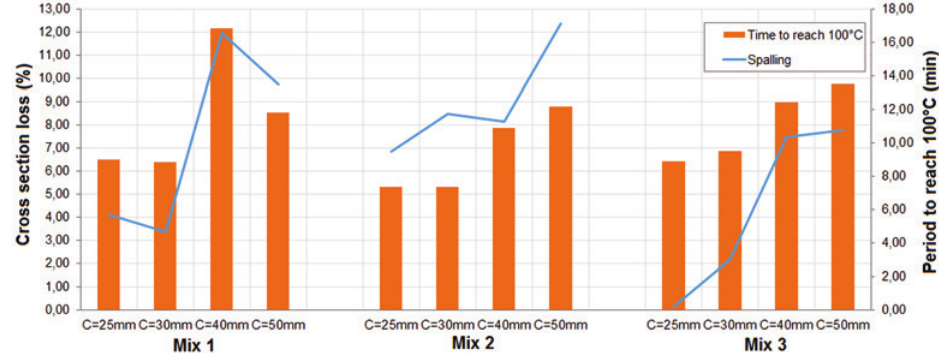
Relation between spalling and the necessary time to reach the temperature of